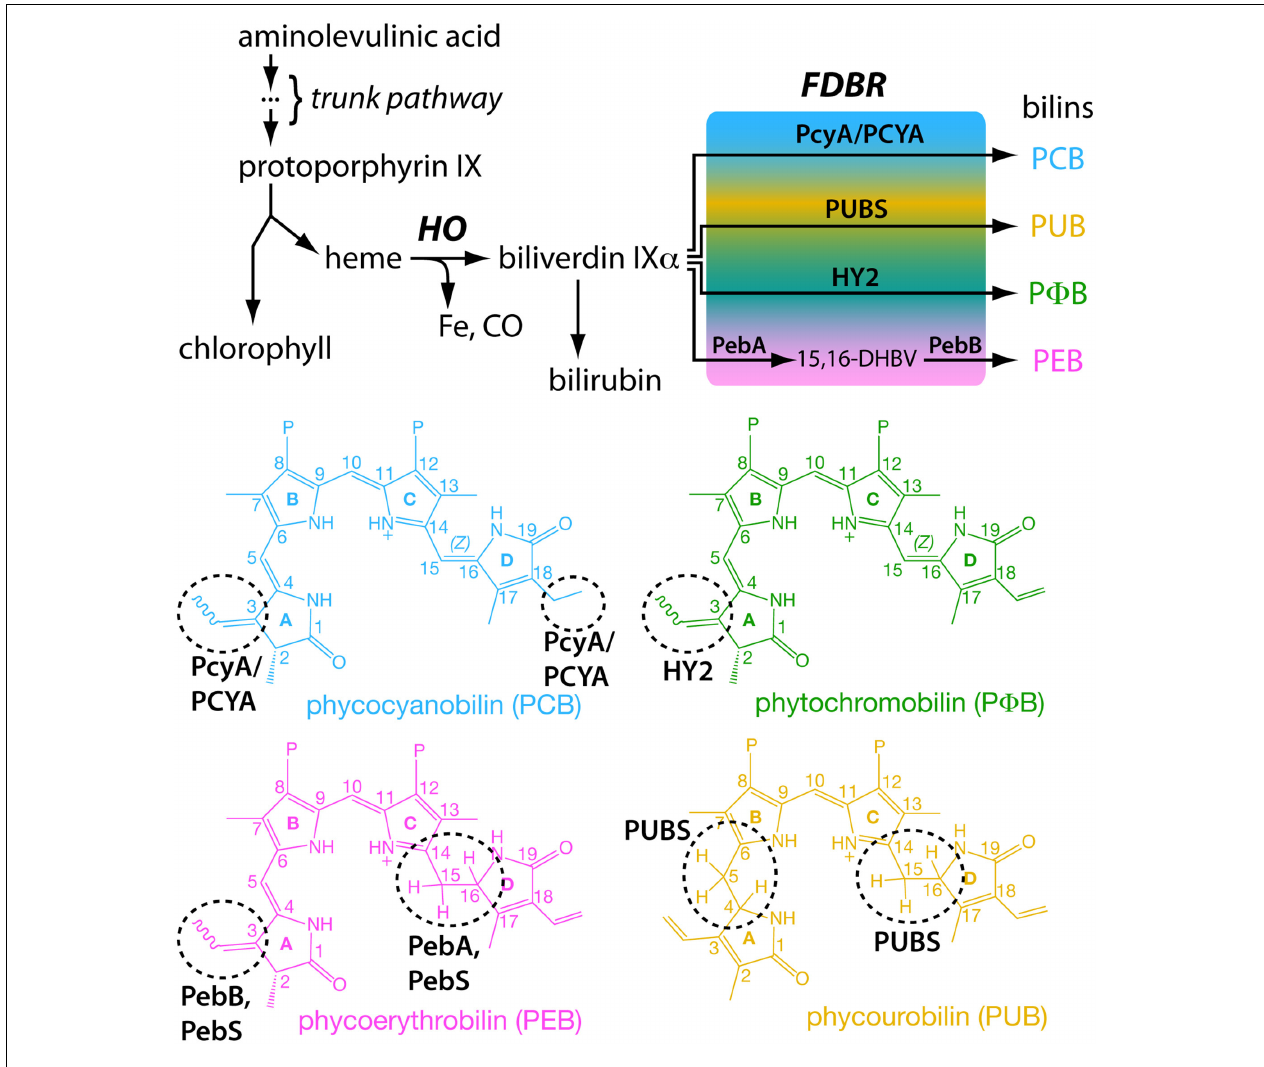
FIGURE 3 | Biosynthesis of bilins. A common tetrapyrrole pathway gives rise to both heme and chlorophyll (top) . Breakdown of heme proceeds via action of a heme oxygenase (HO) and a ferredoxin-dependent bilin reductase (FDBR). Different FDBRs carry out